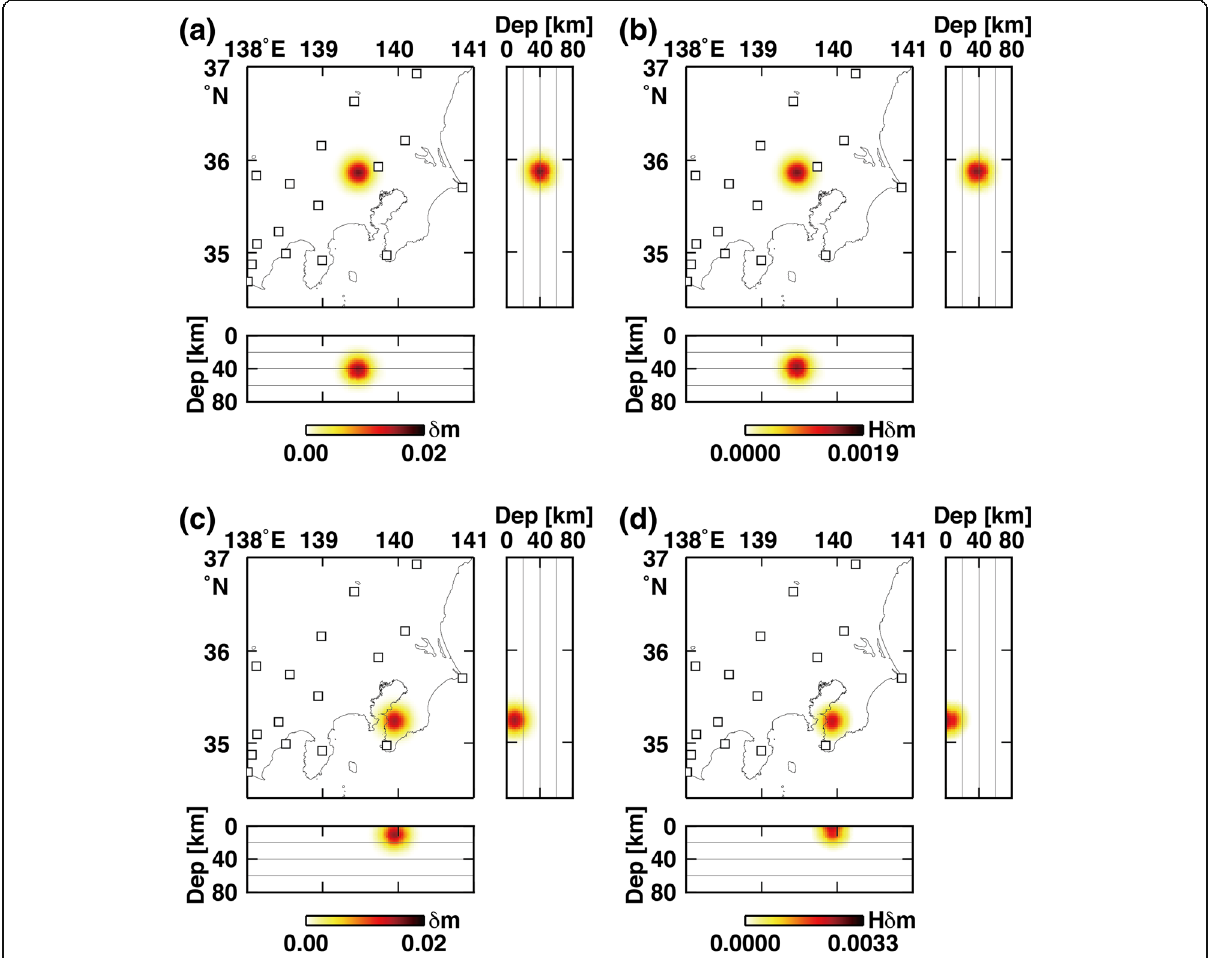
Fig. 17 Point-spreading test. a Model perturbation of Gaussian distribution at a depth of 40 km. b Response H ( m ) δ m of ( a ). c Model perturbation ∼ m ð Þ was assumed in this at a depth of 10 km. d Response H ( m ) δ m of ( c ). H m ð Þ ≈ H